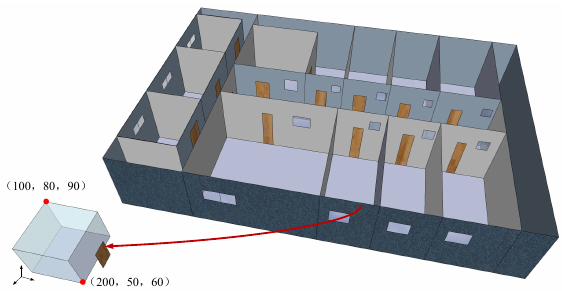
Figure 5. Three - dimensional model of laboratory